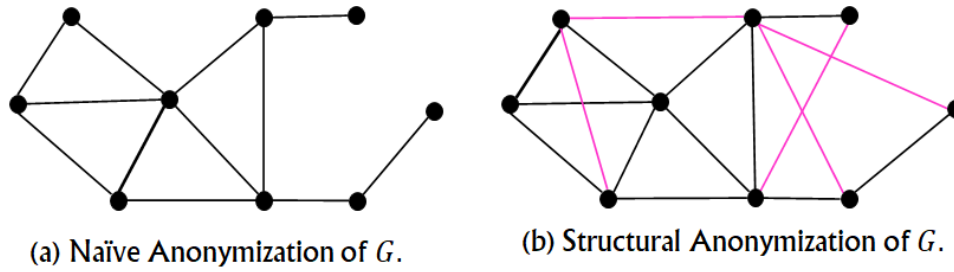
Figure 2. Overview of SN data anonymization by using original G given in Figure